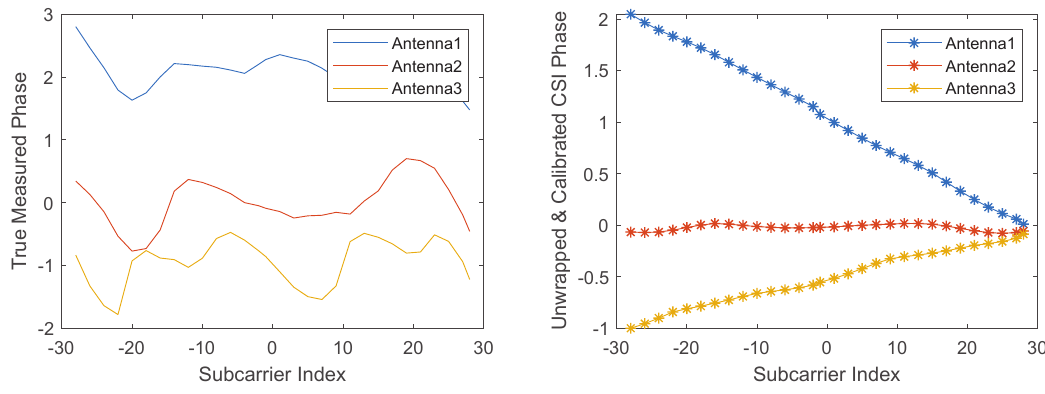
Figure 2. The raw and pre-processed CSI